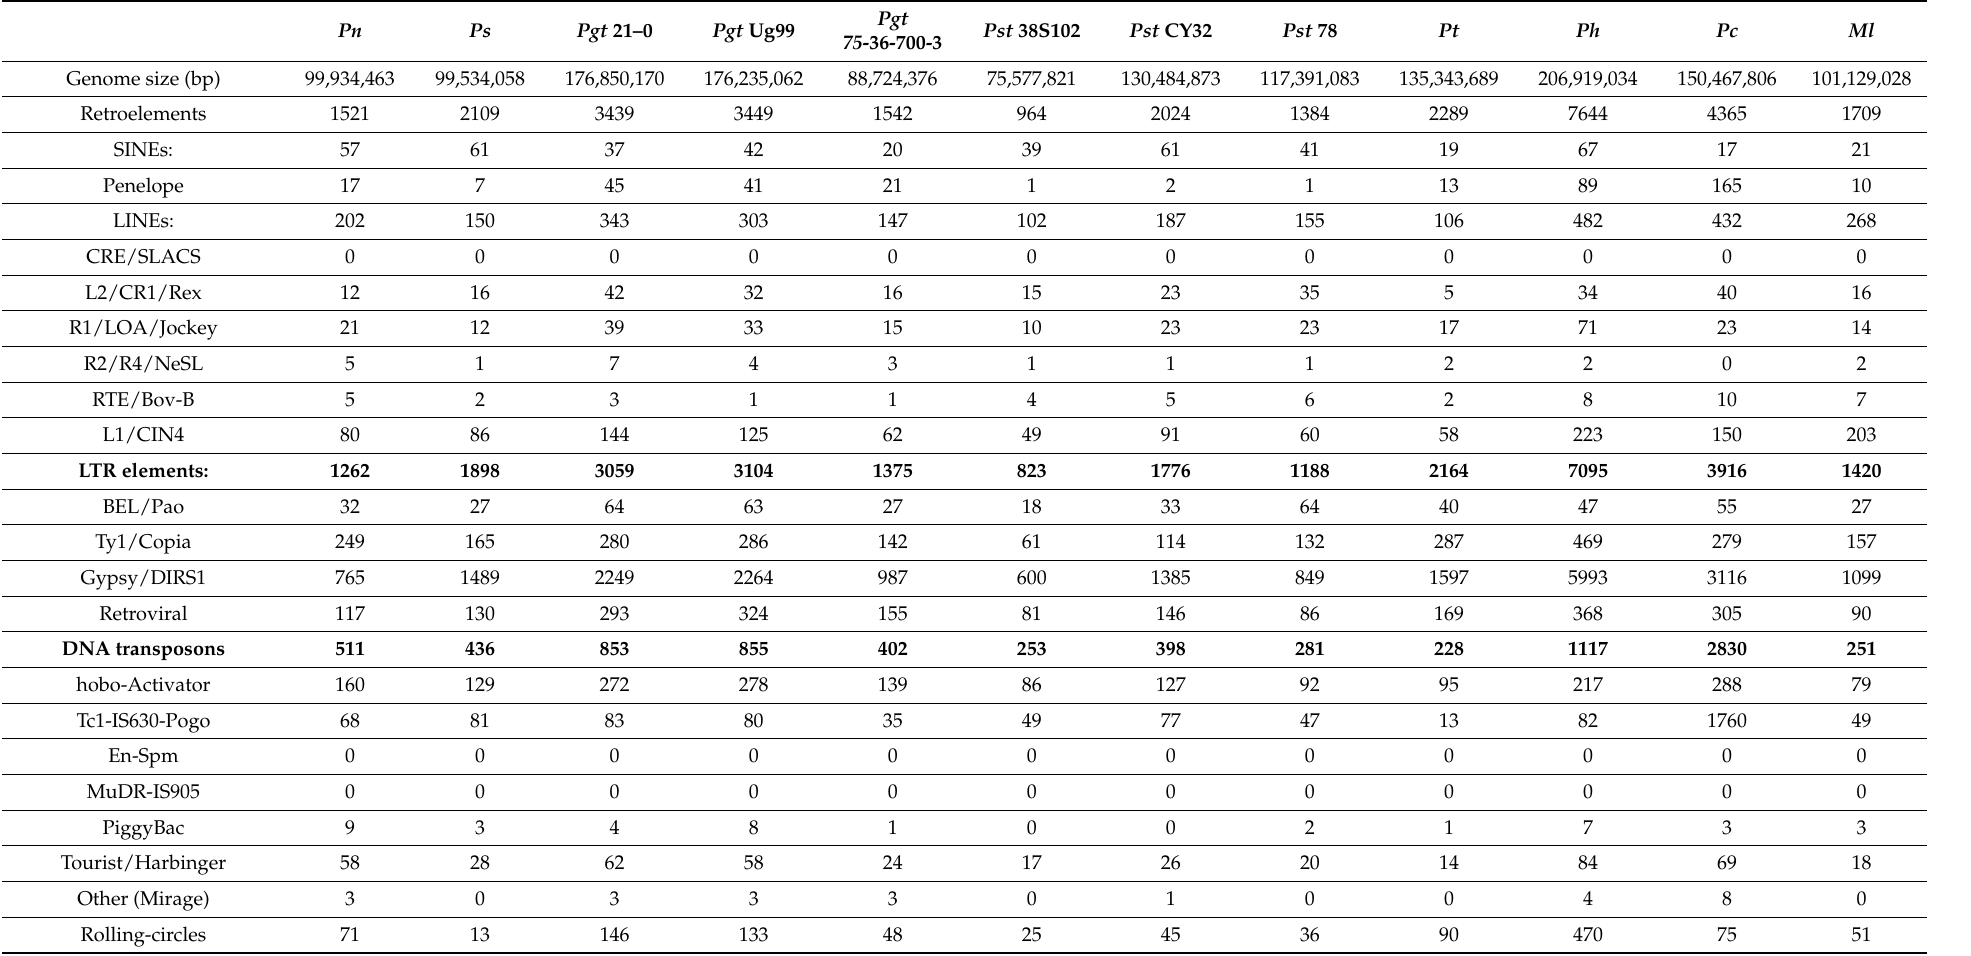
Table 2. Genomic repeat elements metrics of rust pathogen